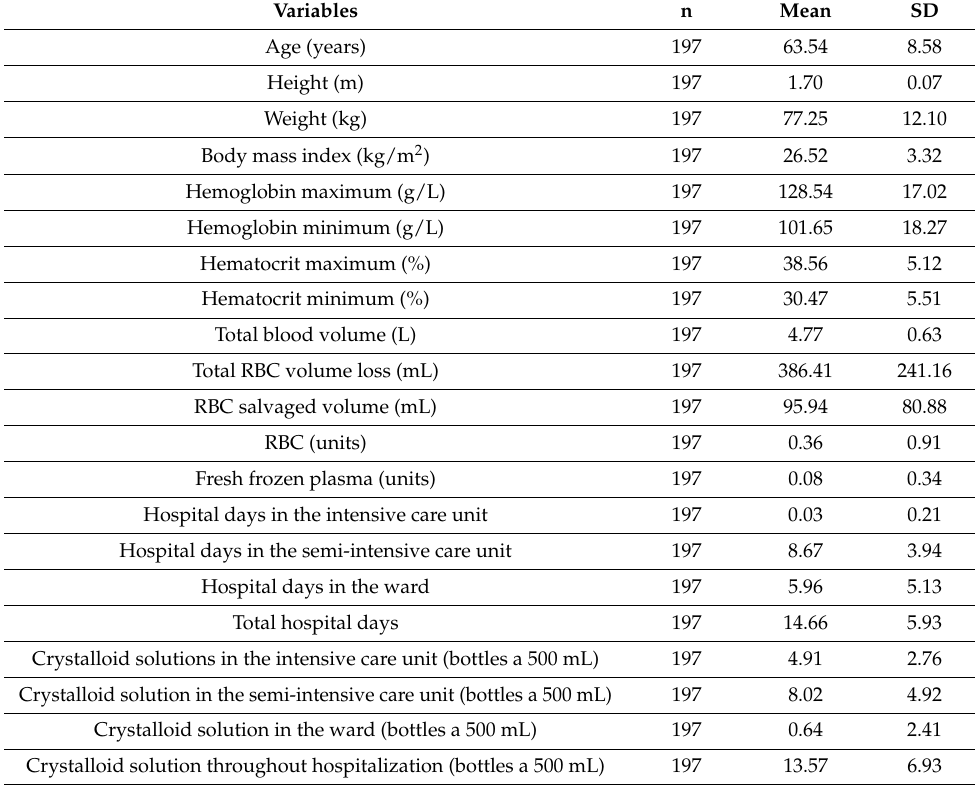
Table 1. Descriptive statistics for continuous variables in the entire study sample of orthopedic